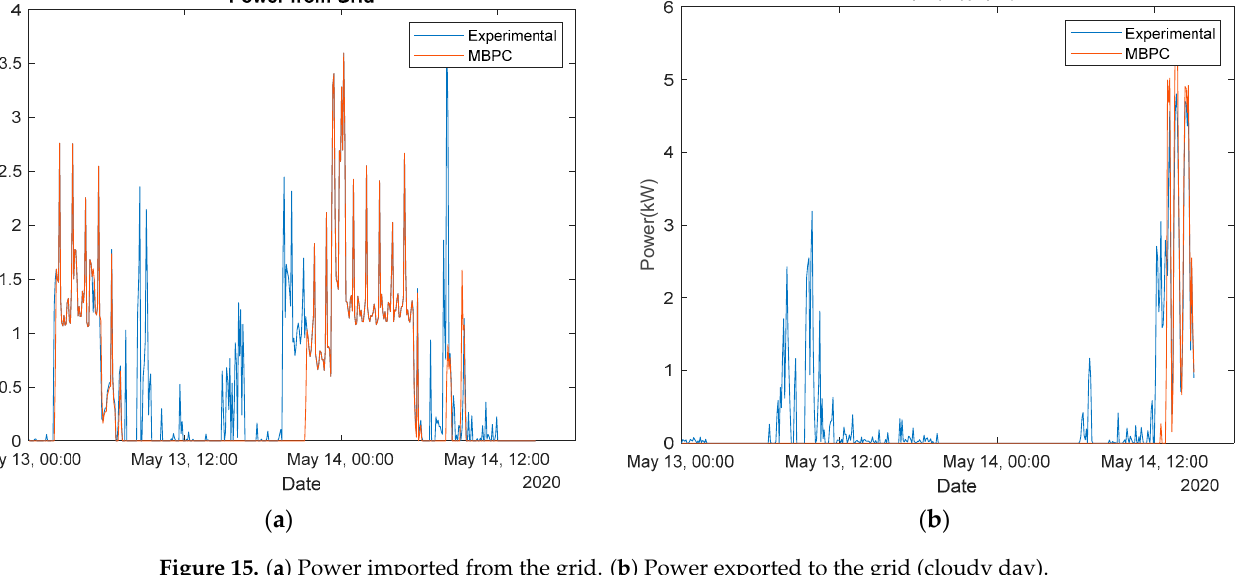
Figure 15. ( a ) Power imported from the grid. ( b ) Power exported to the grid (cloudy day). Visually, we can verify that the actual system must import energy from the grid